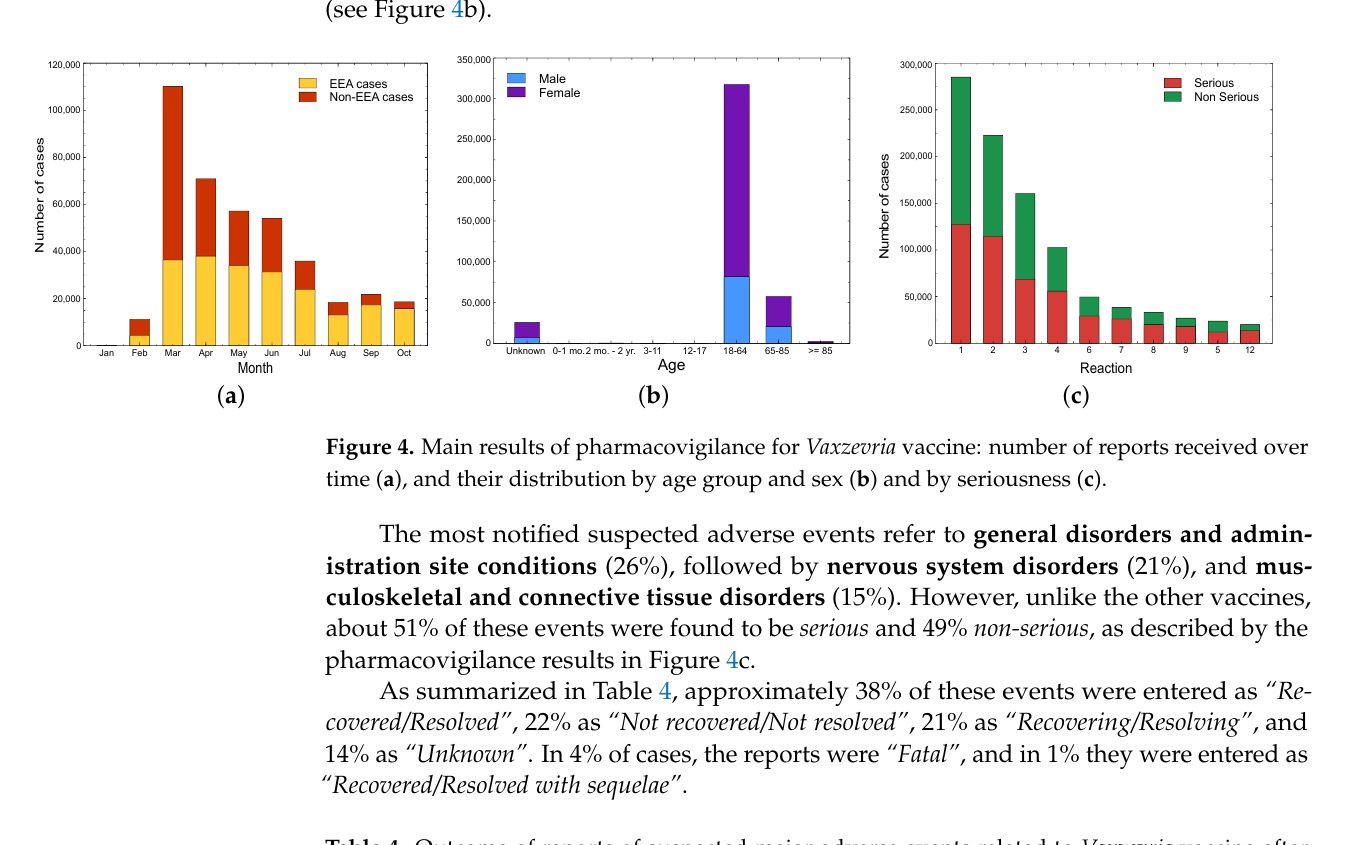
Table 4. Outcome of reports of suspected major adverse events related to Vaxzevria vaccine after 67 million doses administered